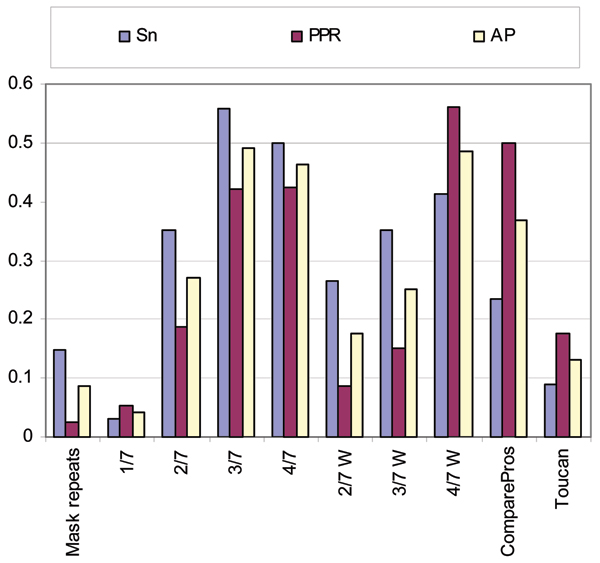
Comparison of performance of CompareProspector, Toucan and our approach on the muscle genes. Sn denotes the combined sensitivity of a particular program for the muscle genes, PPR denotes combined positive prediction rate, AP denotes combined average performance (Table 1). 'Mask repeats' represents the 5000 bp upstream sequences (no gap) for which only the repeat regions were masked were used. Refer to Figure 1 for the description of 't/7' as well as 't/7 W'.